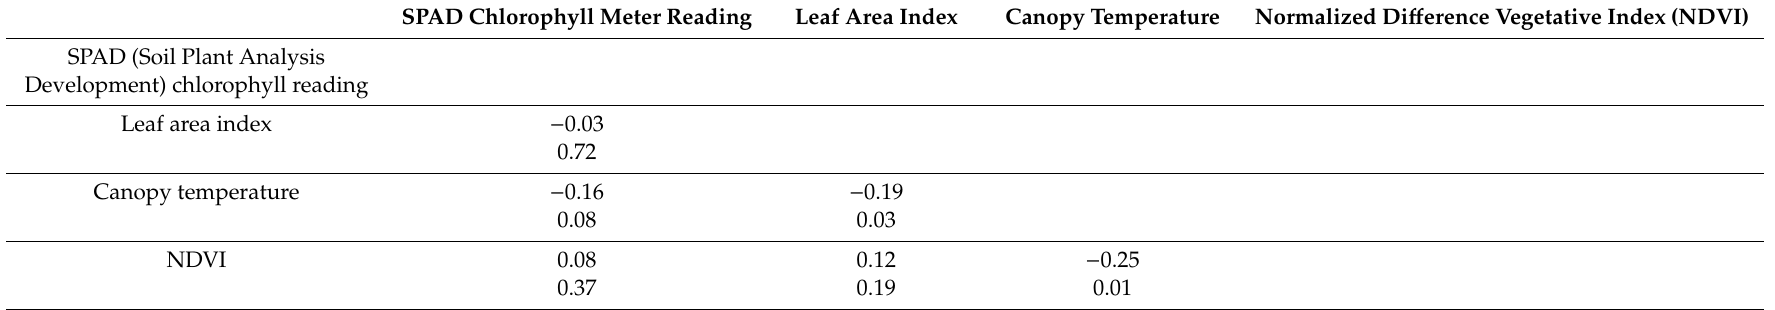
Table 2. Correlation between physiological traits of groundnut mini core collections (above value = correlation and below value are p -values).